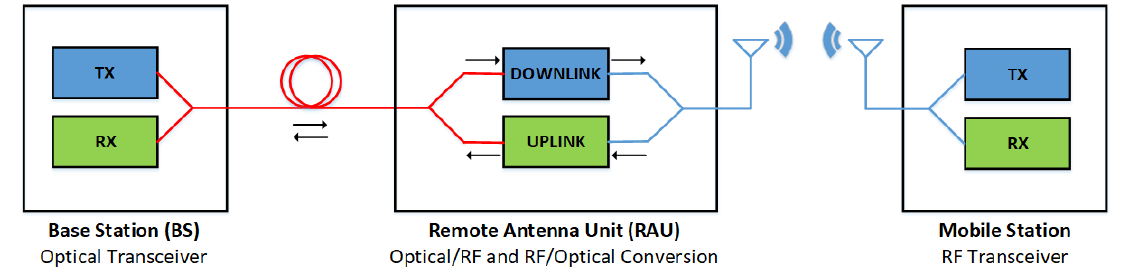
Figure 2. Conceptual scheme of a mixed fiber–wireless communication system based on distributed remote antenna